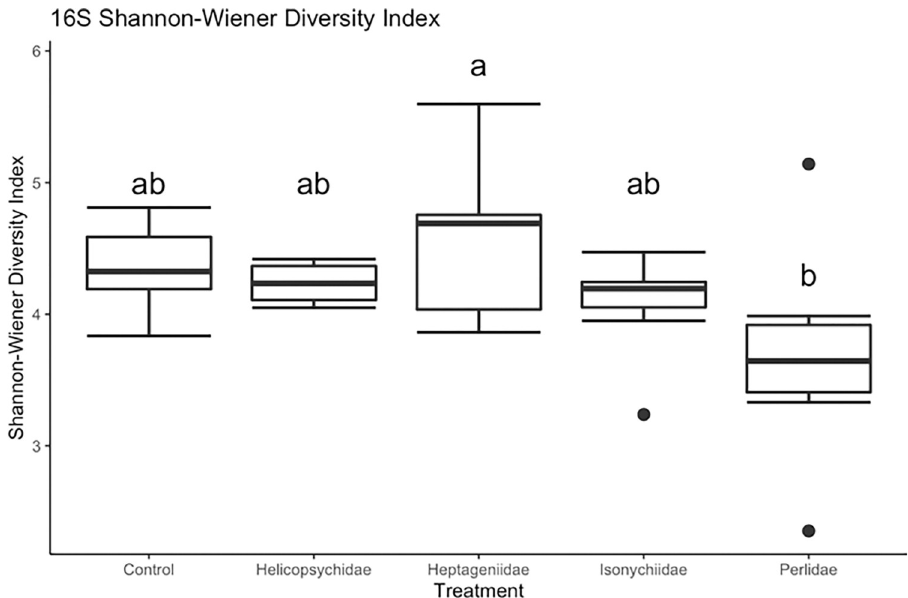
Fig 2. Bacterial (16S) Shannon diversity estimated for lake sturgeon egg surface communities from aquatic insect treatments during time 2 (4 da post fertilization). https://doi.org/10.1371/journal.pone.0277336.g002 16S bacterial beta diversity. PERMANOVA models detected significant additive effects of both sampling time period (PERMANOVA, pseudo-F = 8.716, p = 0.0001) and insect treat- ments (PERMANOVA, pseudo-F = 2.474, p = 0.0001) on 16S microbial community composi- tion. No significant interaction effects were detected (pseudo-F = 1.30, p = 0.088). Community